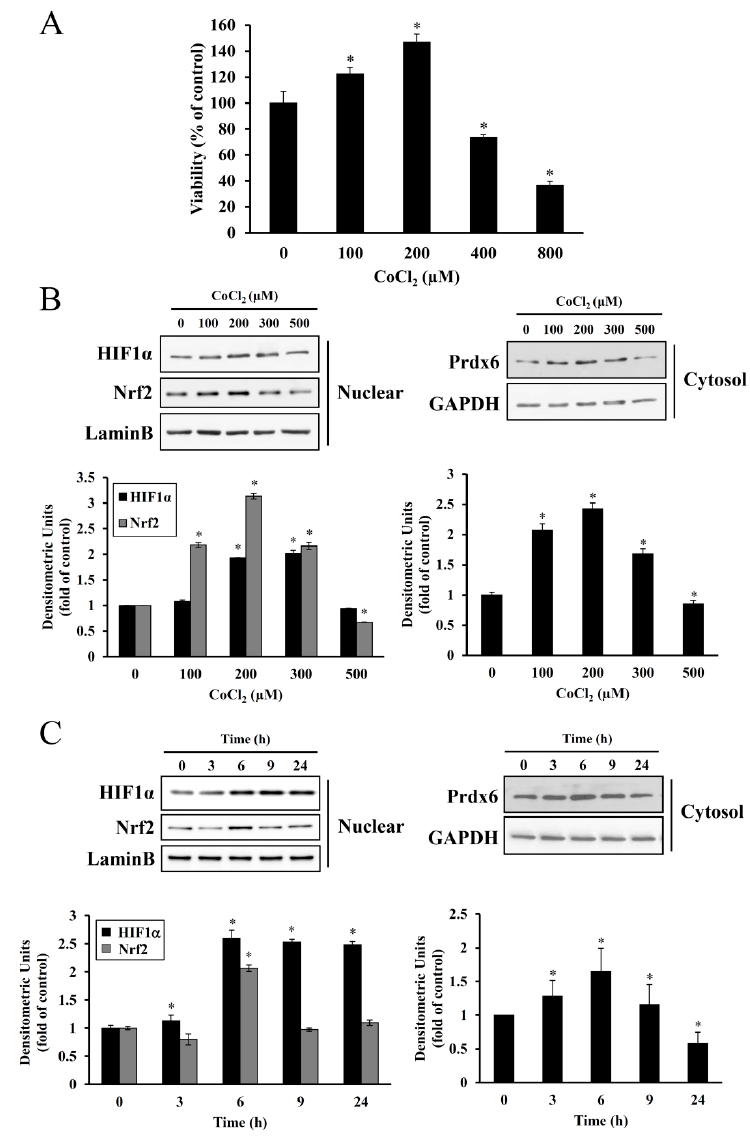
Figure 2. Effect of CoCl 2 on HEI-OC1 cell proliferation and HIF-1 α , NRF-2, and PRDX6 expression. ( A ) Cells were treated with 0–800 μ M CoCl 2 for 6 h, replaced with fresh medium, and further cultured for 24 h. Cell proliferation was then determined using a CCK-8 assay, which measures the production of formazan dye by live cells. Data are presented as means ± SDs for three independent experiments, expressed as a percentage of the untreated control. * p < 0.05, compared with untreated control. ( B , C ) After treatment with 0–500 μ M CoCl 2 for 6 h or 200 μ M CoCl 2 for the indicated times, nuclear or cytosolic proteins were immunoblotted for HIF-1 α , Nrf-2, and Prdx6 expression, respectively. The membranes were then stripped and reprobed with Lamin B or GAPDH polyclonal antibody (a control for protein loading). Individual data were quantified as densitometric units and normalized with expected loading control proteins. Each data represents fold changes relative to untreated controls or the zero time point. Data are presented as means ± SDs for the three independent experiments (* p < 0.05, compared with untreated control or zero time point control).